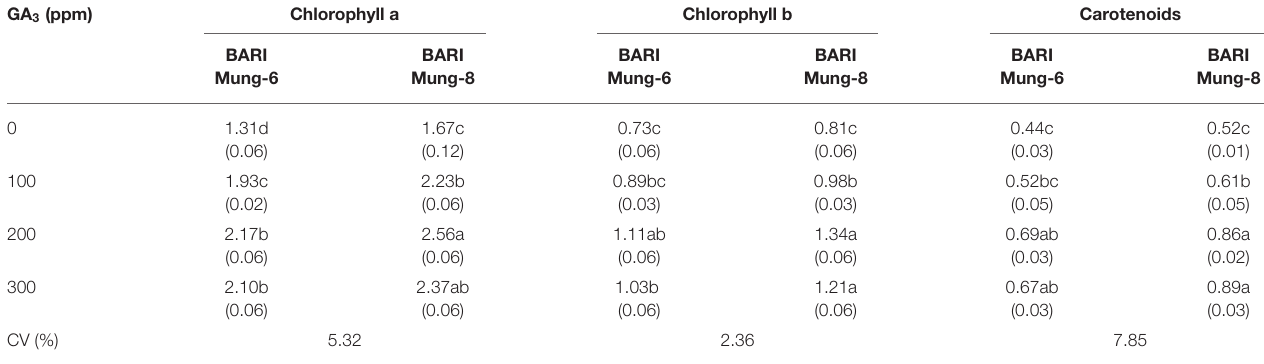
TABLE 4 | Effect of GA 3 on the photosynthetic pigments (mg g − 1 fresh weight) in the leaves of V. radiata varieties. GA 3